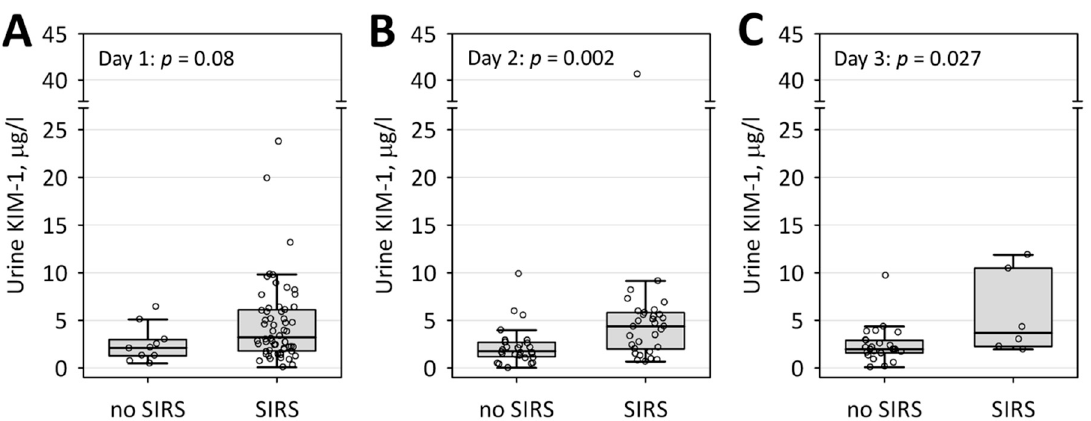
Figure 2. Urinary concentrations of KIM-1 among patients with and without systemic inflammatory response syndrome (SIRS) on day 1 ( A ), 2 ( B ), and 3 ( C ) of the study. Data are shown as median (central line), lower/upper quartile (box), and nonoutlier range (whiskers), circles denote the row data.